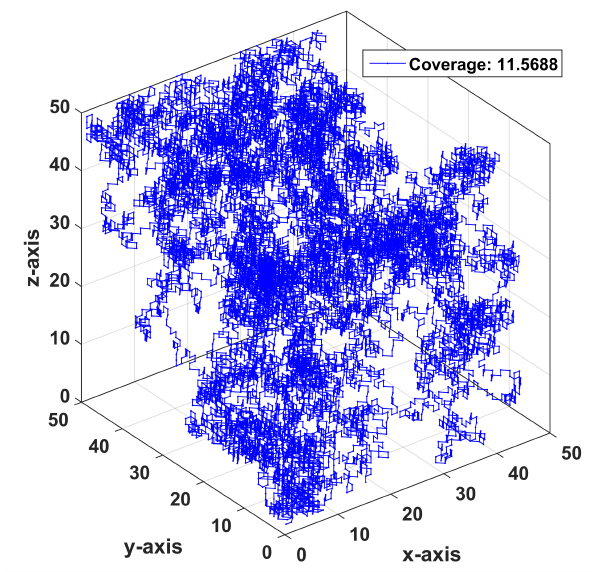
Figure 12. Simulation of motion for 10,000 iterations of the